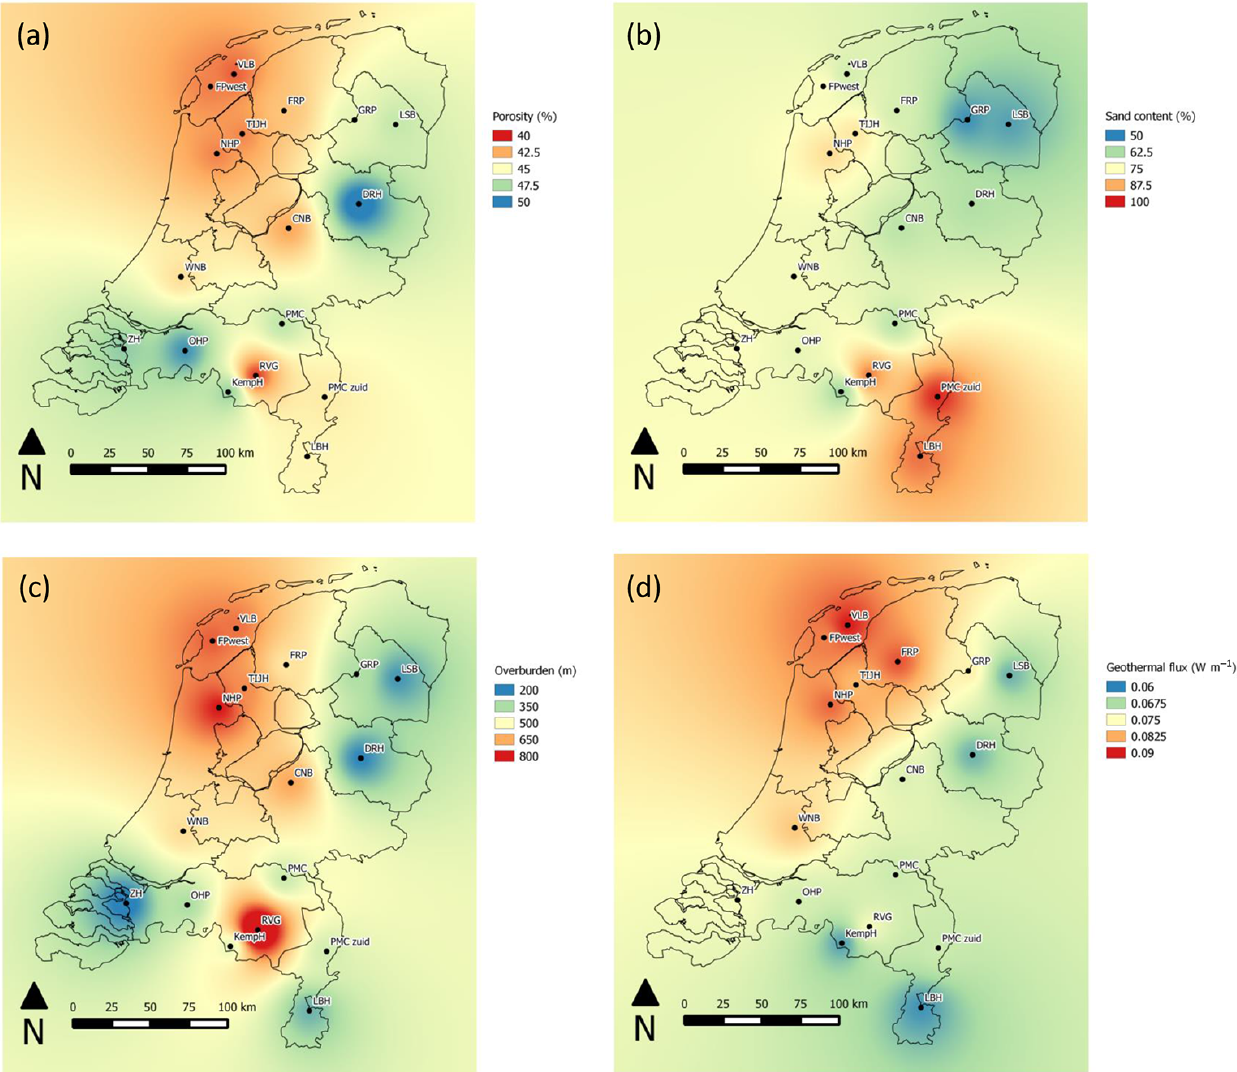
Figure 2. (a) Averaged mid-depth porosity variability of the post-Rupelian overburden, (b) distribution of the average sand content in the post-Rupelian overburden, (c) depth of the top of the Rupel Formation, also representing the thickness of the overburden (m), (d) spatial distribution of geothermal heat flux values (Wm 3 ). The flux is significantly higher in the (north)west than the (south)east of the country.